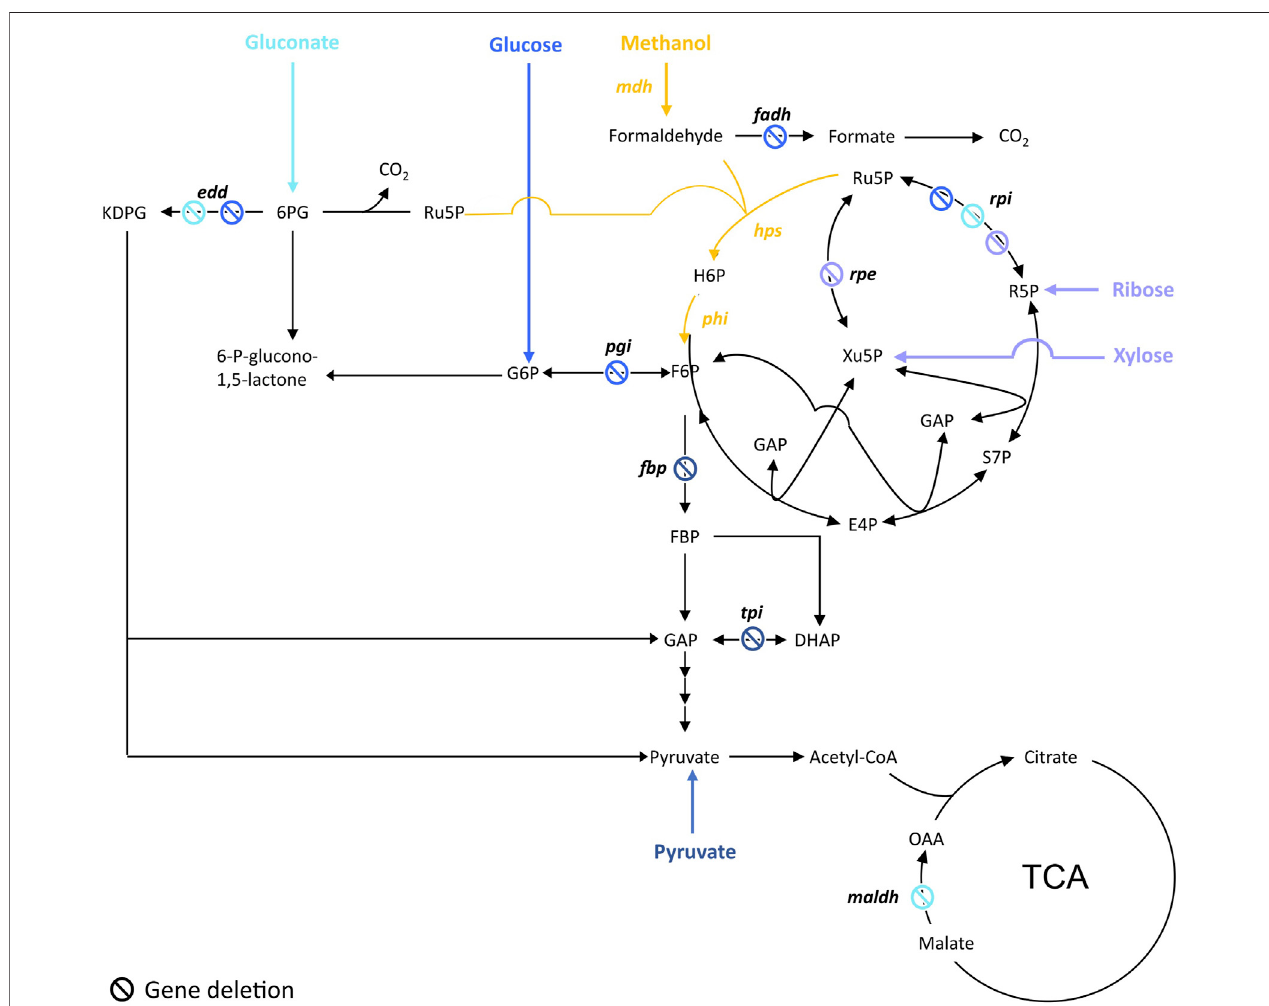
FIGURE 1 | Targeted genes to construct methanol-dependent strains in E. coli . Adapted from (Wang et al., 2020b). Engineered synthetic methanol-dependent strain co-assimilating gluconate (in light blue) by (Meyer, et al., 2018); co-assimilating glucose (in blue) by (Bennett, et al., 2020b); co-assimilating ribose by (Chen, et al., 2018) or xylose by (Chen, et al., 2018; Chen, et al., 2020) (in purple); co-assimilating pyruvate (in dark blue) by (Keller, et al., 2020). Enzymes are written in bold. edd, 6- phosphogluconate isomerase; fadh, formaldehyde dehydrogenase; hps, 3-hexulose-6-phosphate synthase; maldh, malate dehydrogenase; mdh, methanol dehydrogenase; pgi, glucose-6-phosphate isomerase; phi, 6-phospho-3-hexuloisomerase; rpe, ribulose-3-phosphate epimerase; rpi, ribose-5-phosphate isomerase. Ac-CoA, acetyl-CoA; E4P, erythrose-4-phosphate; F6P, fructose-6-phosphate; FBP, fructose-1,6-biphosphate; GAP, glyceraldehyde-3-phosphate; DHAP, dihydroxyacetone-phosphate, H6P, hexulose-6-phosphate; KDPG, 2-keto-3-deoxy-6-phosphogluconate; 6 PG, 6-phosphogluconate; R5P, ribose-5-phosphate; Ru5P, ribulose-5-phosphate; S7P, sedoheptulose-7-phosphate; SBP, sedoheptulose-1,7-biphosphate; Xu5P, xylulose-5-phosphate.